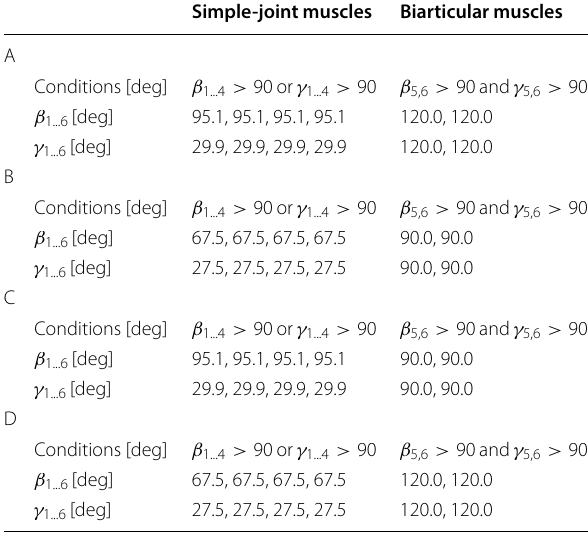
Table 5 Geometric conditional angles β i and γ i for